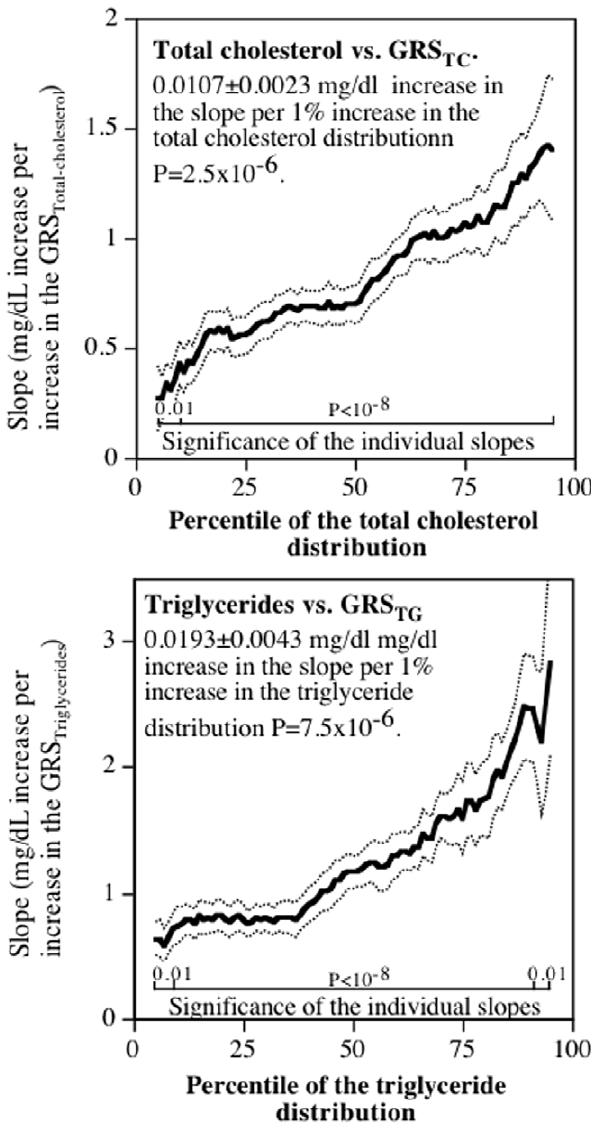
Figure 3. Slopes for plasma total cholesterol concentrations versus GRS Total cholesterol and plasma triglyceride concentra- tions versus GRS Triglycerides (Y-axis) by the percentiles of the lipid distribution (X-axis). Lighter lines designate 6 one standard error.